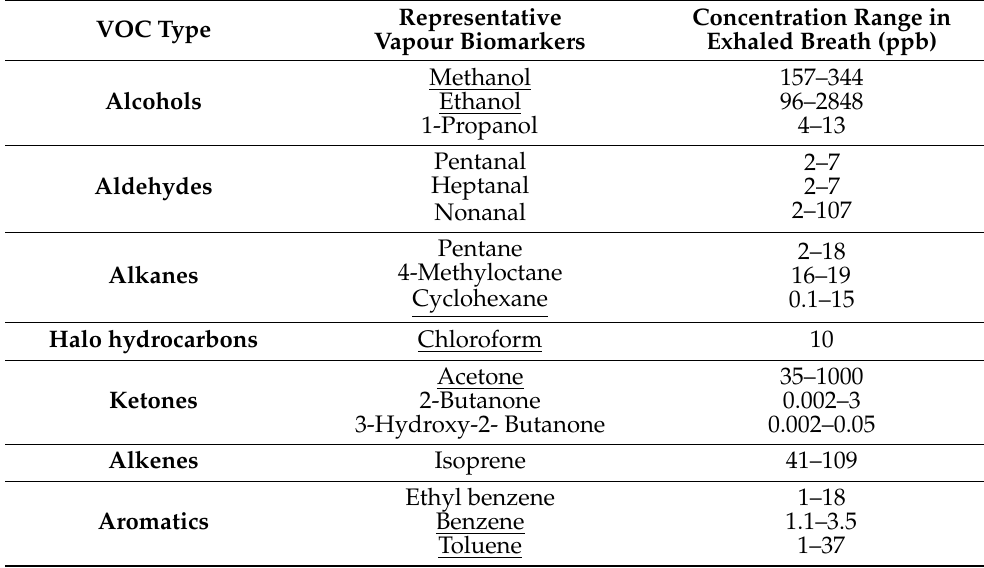
Table 2. Cancer biomarkers among breath volatile organic compound (VOC) [77–79,82,83], under- lined vapours are used in this